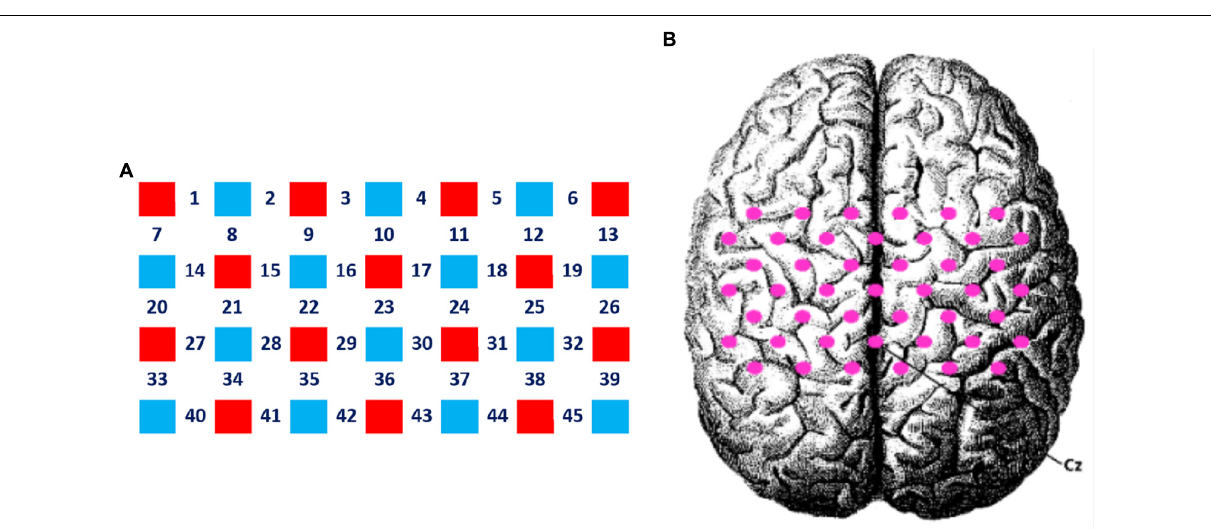
FIGURE 2 | Layout of the fNIRS channels. (A) The red block represents the emitter and the blue block represents the detector. Twenty eight optodes (14 emitters and 14 detectors) were attached to the frontal-parietal cortex in a 4 × 7 multi-channel probe holder forming 45 measurement channels. (B) The pink dot represents the measurement channels, following the international 10–20 system. Channel 36 was placed at the Cz